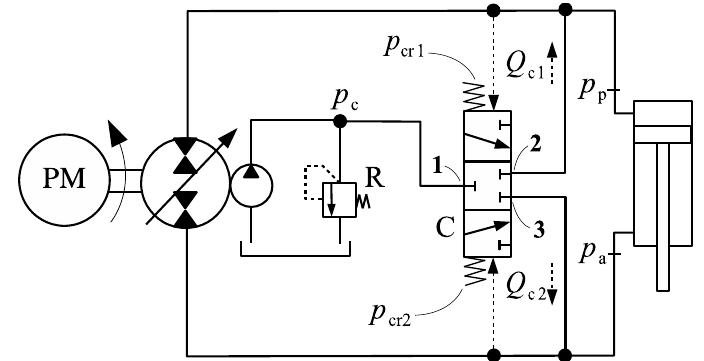
Figure 20. Circuit using directional valve with different pressure sets.